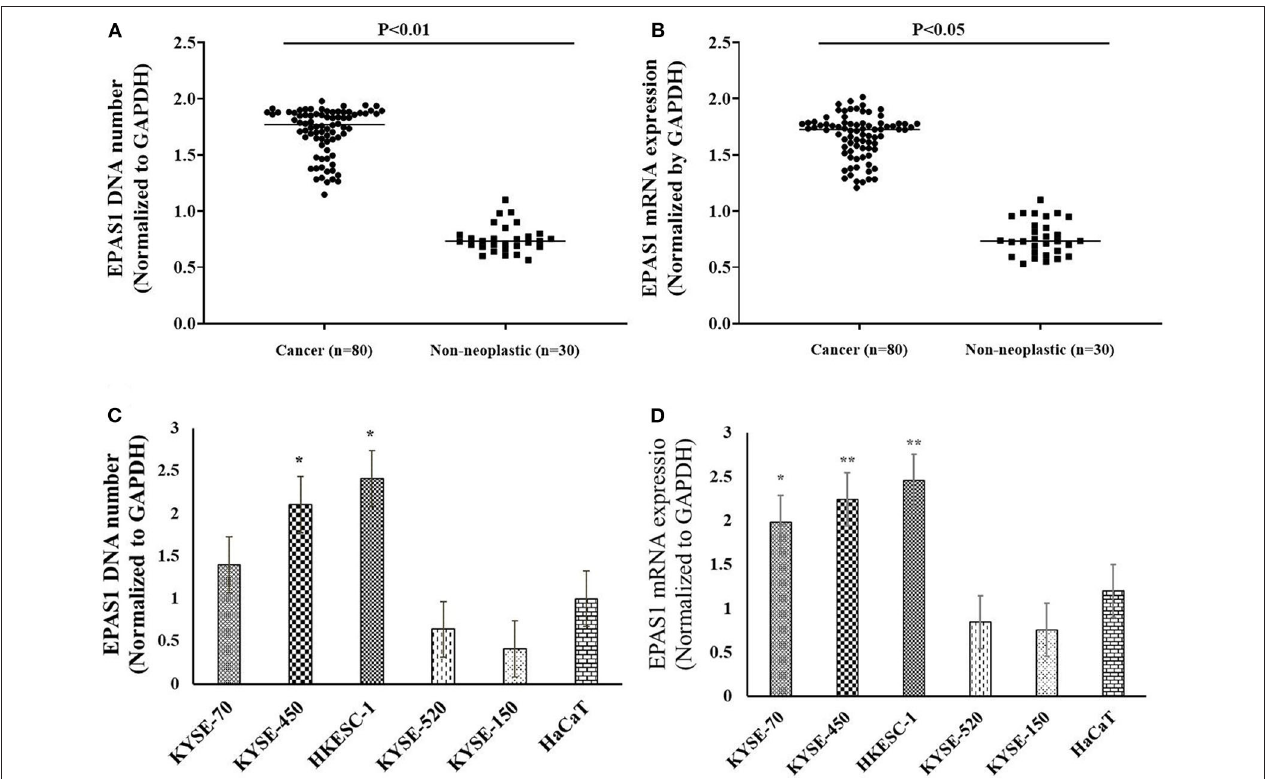
FIGURE 3 | EPAS1 DNA number and mRNA expression profile in patients with ESCC and cell lines. (A) Patients with ESCC exhibited significant amplifications of EPAS1 DNA when compared with noncancerous samples ( p < 0.01). (B) Similarly, a significant overexpression of EPAS1 mRNA in ESCC was noted in comparison to that of noncancerous tissues ( p < 0.05). (C) Cell lines showed higher or lower EPAS1 DNA number when compared to that of noncancerous keratinocyte (HaCaT) cells. (D) Higher or lower EPAS1 mRNA was noted in ESCC cancer cells when compared with nonneoplastic HaCaT cells. Results are shown as mean ± SD, and significance level was taken at p < 0.05. * p < 0.05, and ** p <